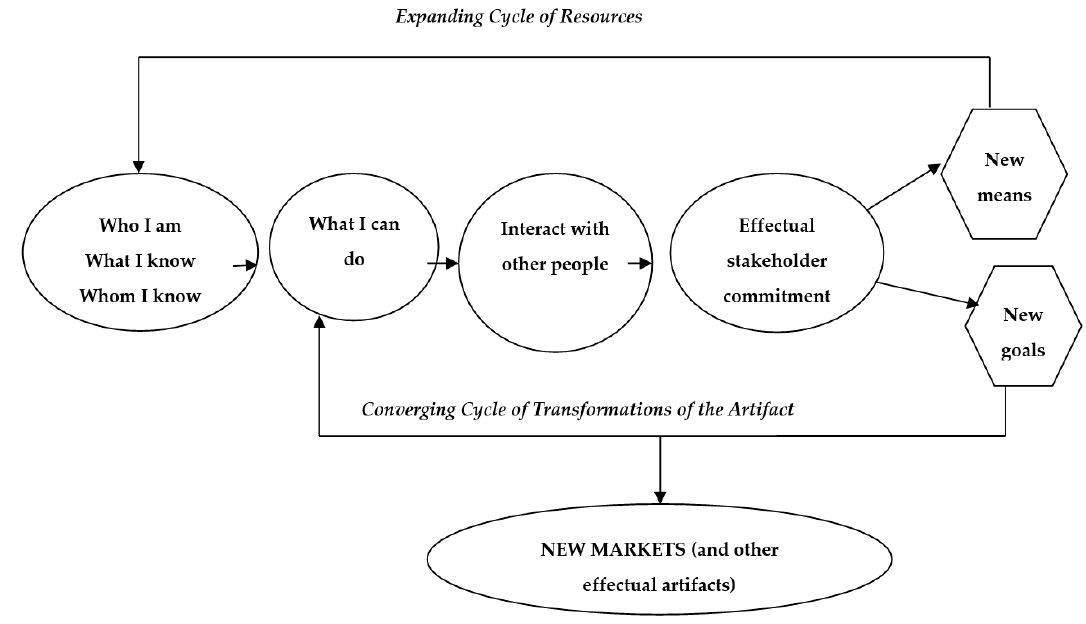
Figure 1. Dynamic Model of Effectuation